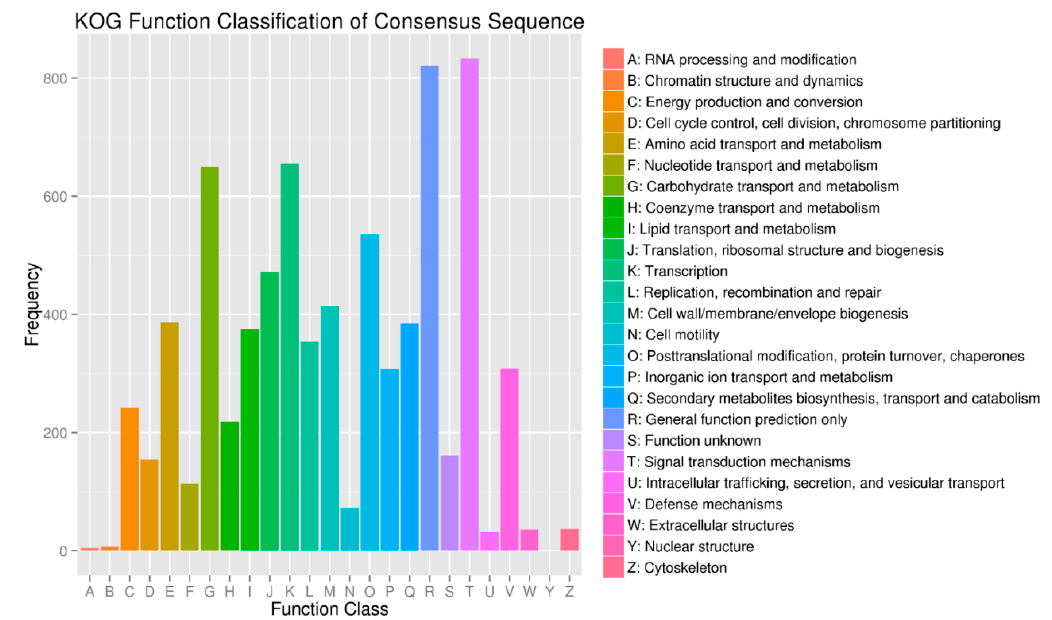
Figure 6. KOG function classification of target genes of differentially expressed miRNAs. The Y axis stands for the frequency of target genes while the X axis stands for the function classification of target genes. Int. J. Mol. Sci. 2019 , 20 , x FOR PEER REVIEW